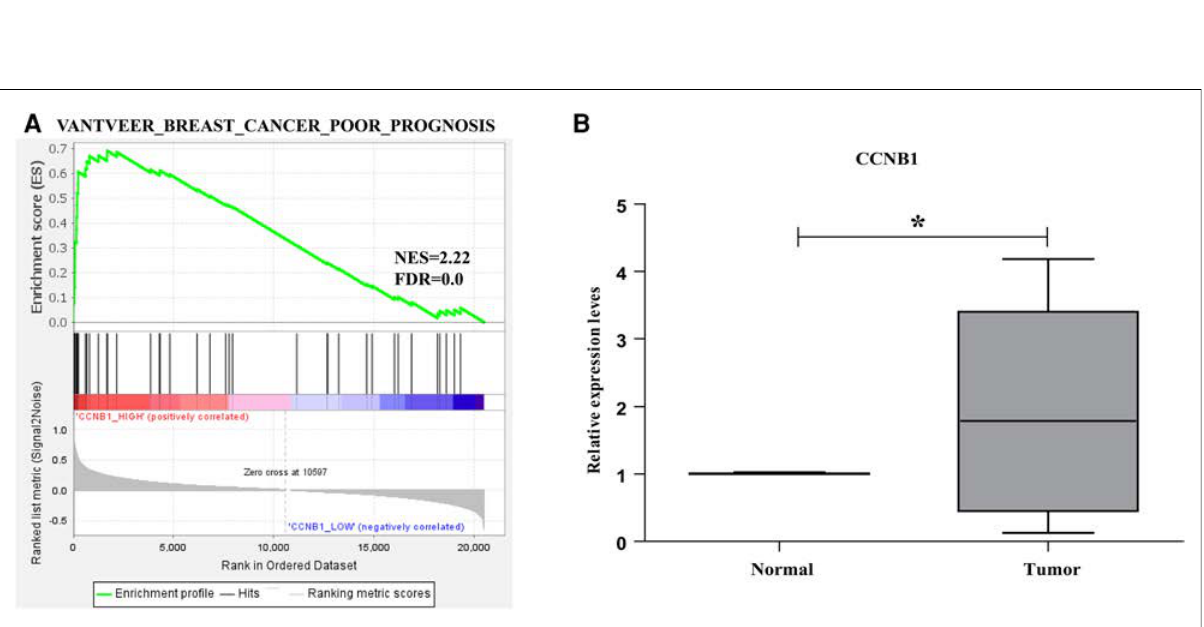
FIGURE 7 Enrichment plots from GSEA. ( A ) CCNB1 was positively related tothe poor prognosis of BC. ( B ) CCNB1 genes validation in nine BC patient ’ s